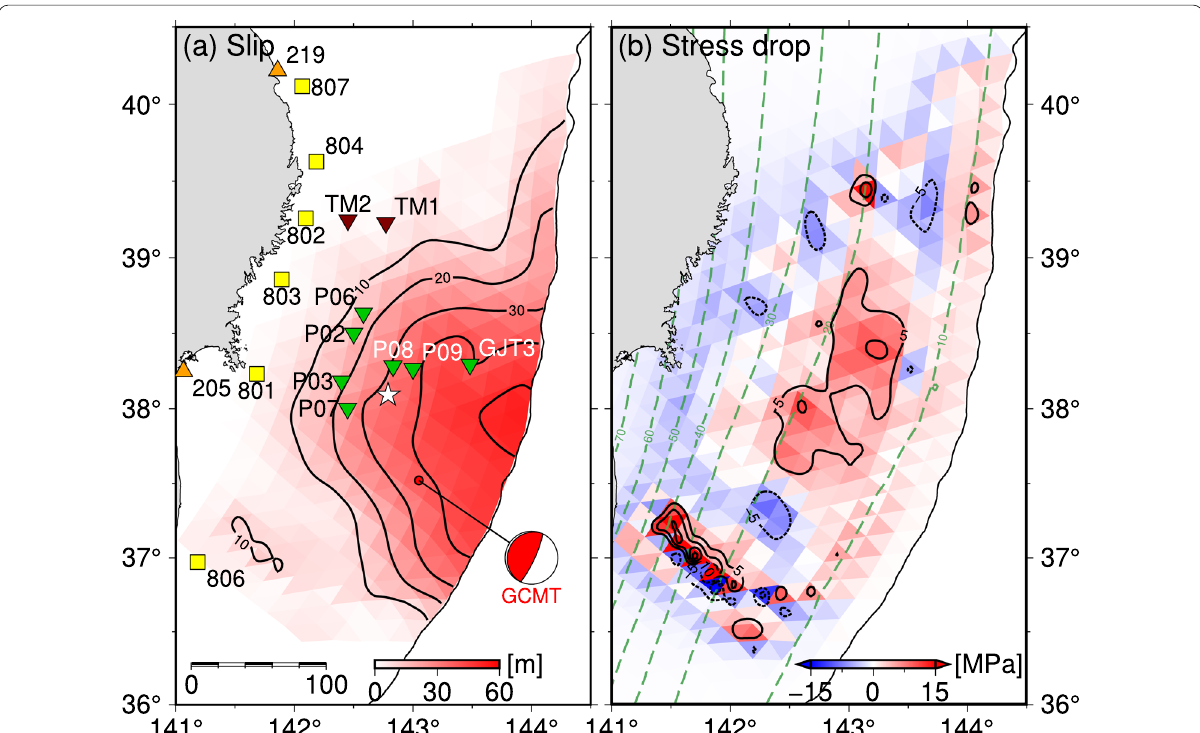
Fig. 4 Slip and stress distributions of the 2011 Tohoku-Oki earthquake. a Slip distribution obtained in the present study. Contour lines are drawn at 10 m intervals. b Stress drop distribution calculated from the slip distribution. Contour lines are drawn at 5 MPa intervals. Green dashed lines denote the iso-depth contour of the plate interface at 10 km